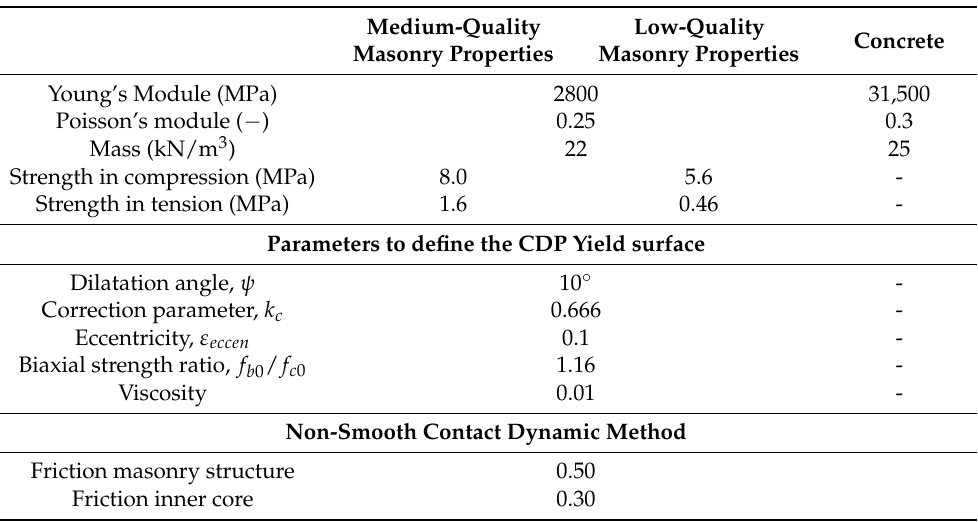
Table 1. Materials’ parameters used in the continuous and the discontinuous